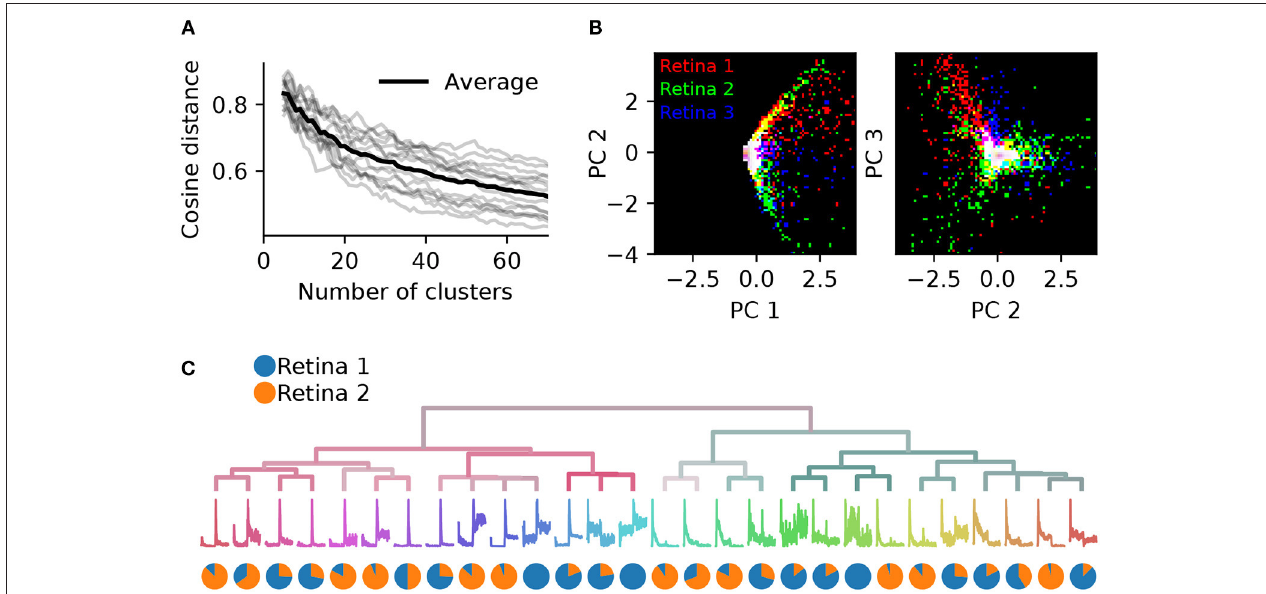
FIGURE 8 | Systematic differences in RGC activity between individual retinas prevents data pooling. (A) , Gray lines show, for each pair of six retinas, the average cosine distances between the top eight PCA projections of the best matching chirp PSTHs (explaining 78% variance), as a function of the number of clusters generated. The black line is the average across all data sets. Individual retinas show high variability even for a large number of clusters, indicating considerable differences between preparations. (B) , The first and second (left) and second and third PCA projections plotted against each other for three retinas (indicated by color). Each retina occupies a different region in PCA space. (C) , Dendrogram obtained by clustering a data set generated from randomly selecting 500 neurons from two retinas. The pie charts show the relative proportion of neurons from each retina in each cluster. Most clusters exhibit a strong bias toward one of the two retinas.